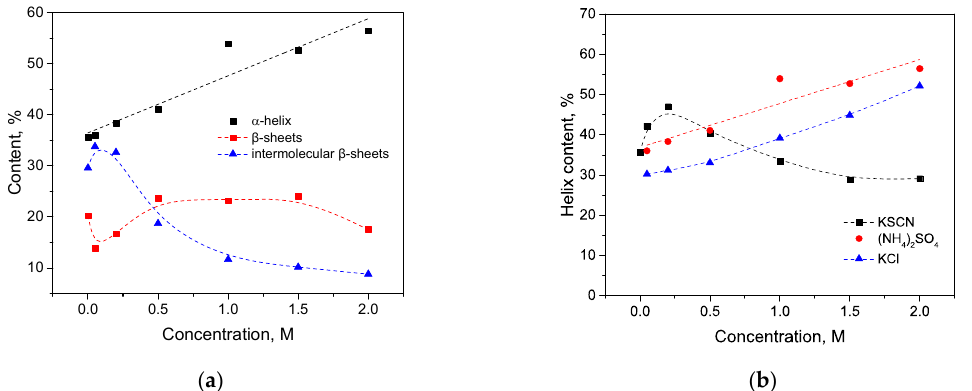
Figure 18. Changes in the secondary structure of HSA in the interaction with (NH 4 ) 2 SO 4 ( a ) and salt-specific effects on the α-helical secondary structure of HSA( b ) in 10% wt. aqueous solution at 80 °C. After a 10-min exposure at 80 °C in the solution of (NH 4 ) 2 SO 4 , the maximum of the Amide I region shifts by 1622 cm -1 for all concentrations towards the region of intermolecular β-sheets, which become the prevailing elements in the secondary structure of trypsin (Figure 19a). However, this effect was smaller than in the case of KSCN and KCl (Figure 19 b).